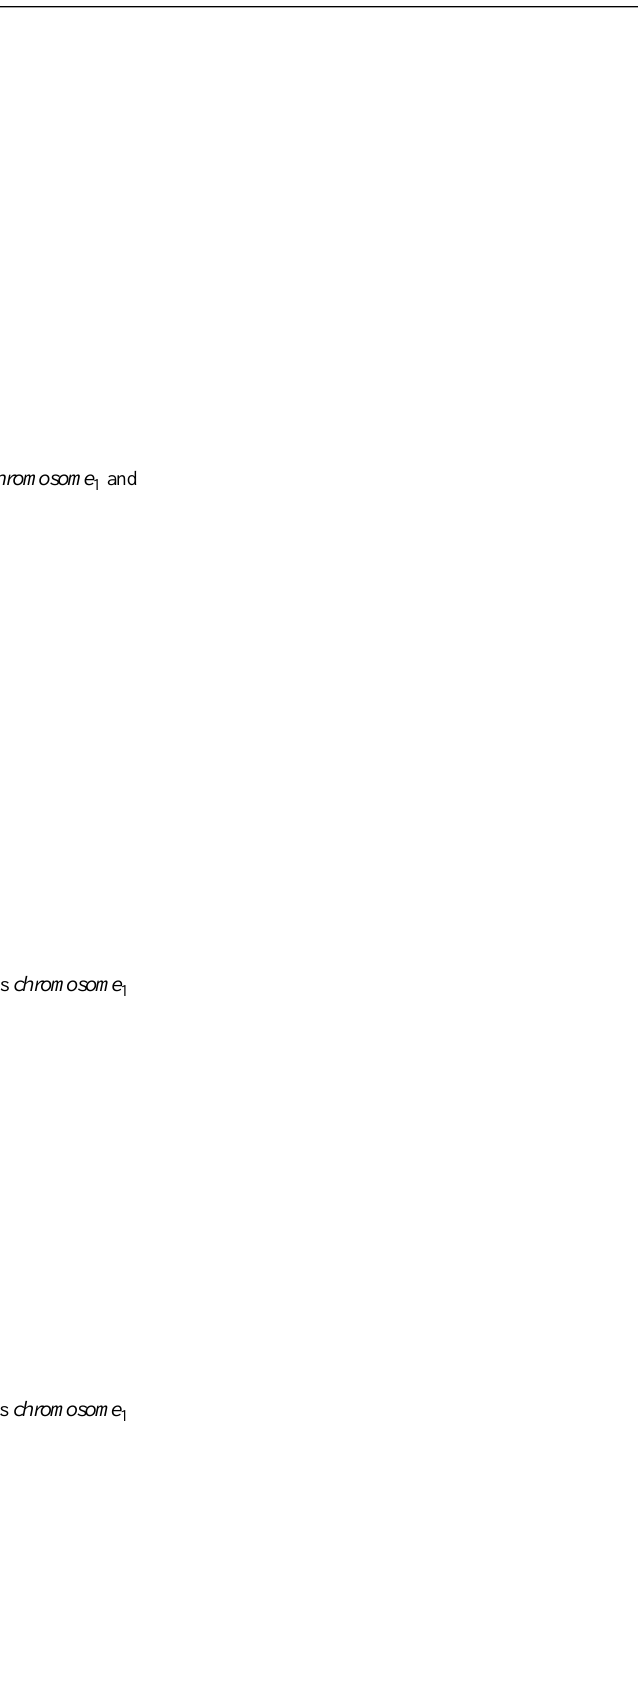
Textbox 1. Pseudocode of the hybrid Taguchi-genetic